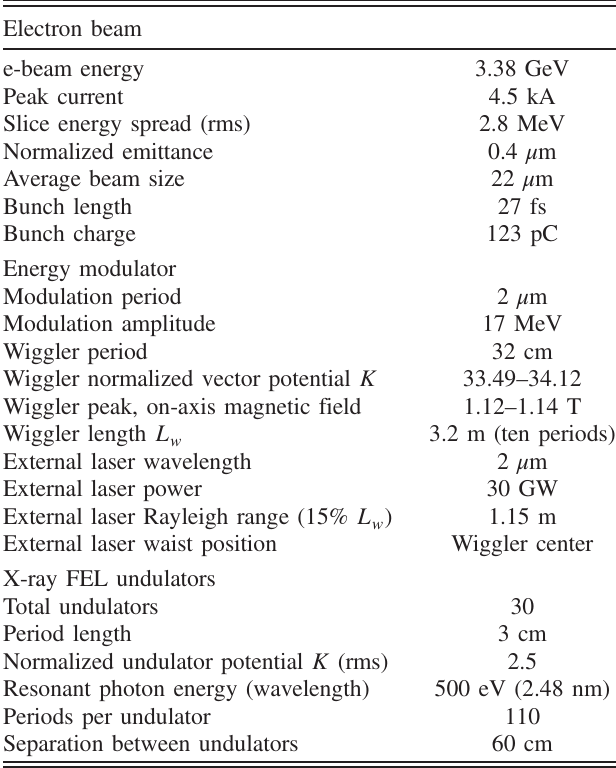
TABLE I. Simulation